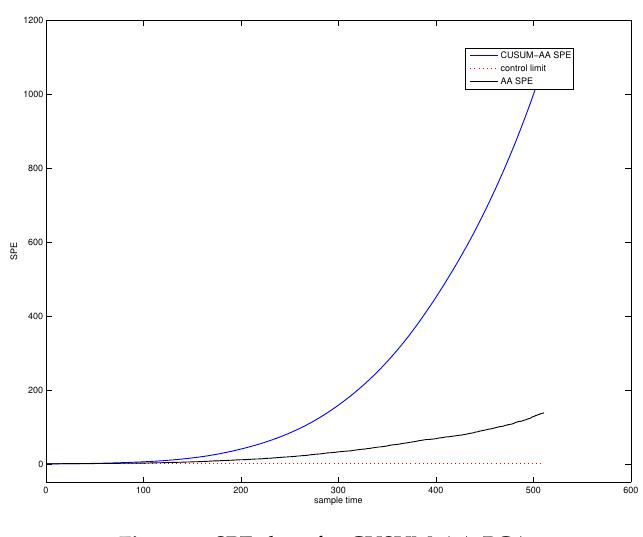
Figure 7. SPE chart for CUSUM-AA-PCA.